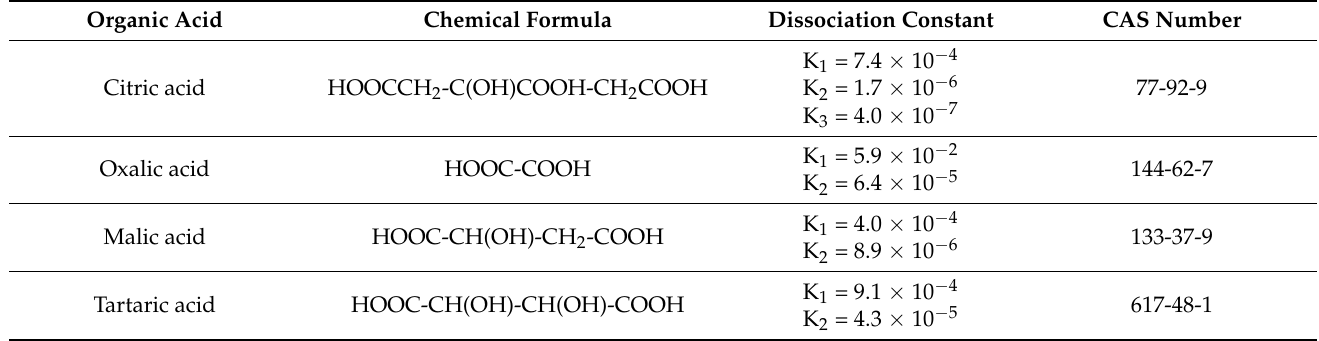
Table 2. Basic properties of low-molecular-weight organic